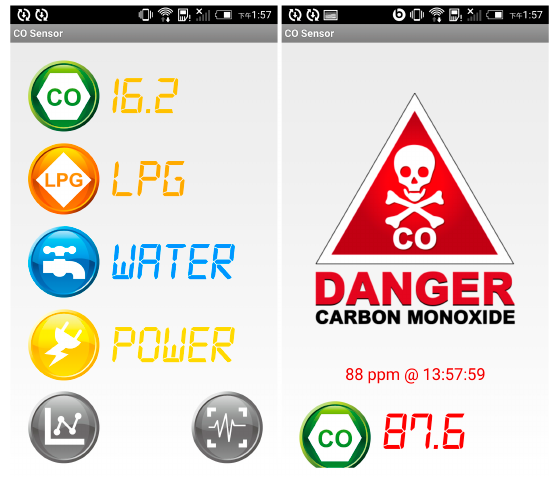
Figure 11. Screenshots of the mobile application for the COSWOB data visualization.